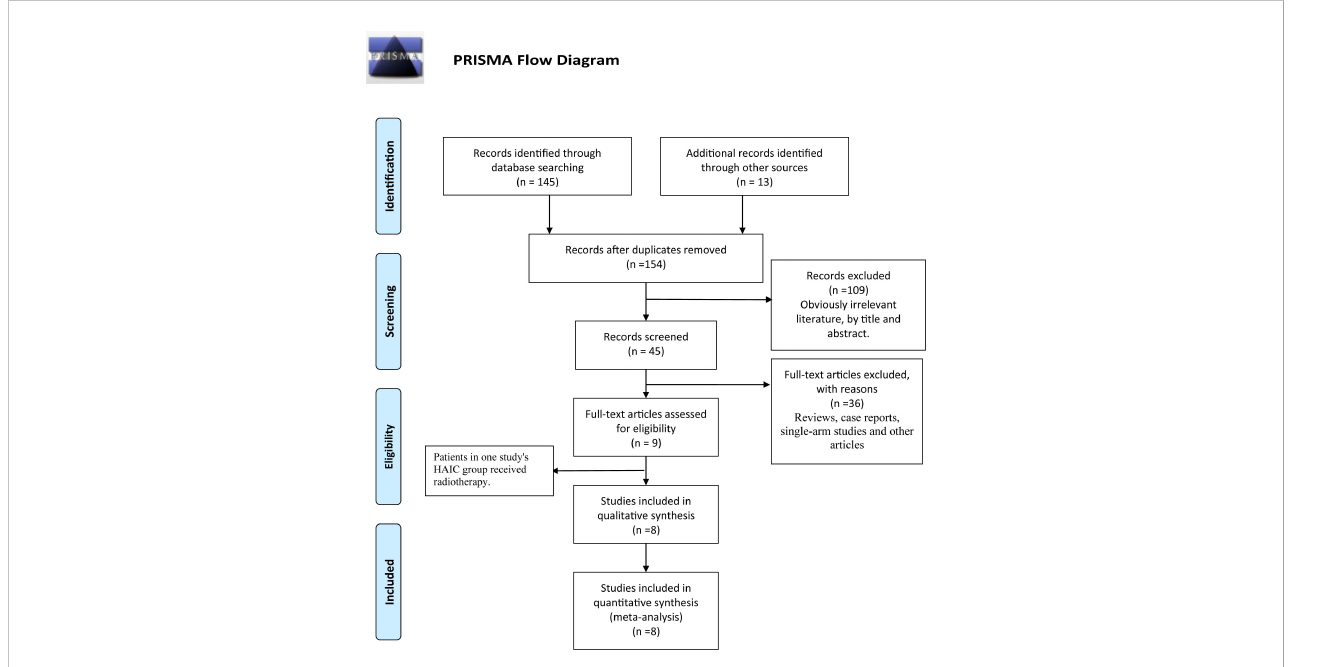
FIGURE 1 PRISMA fl ow